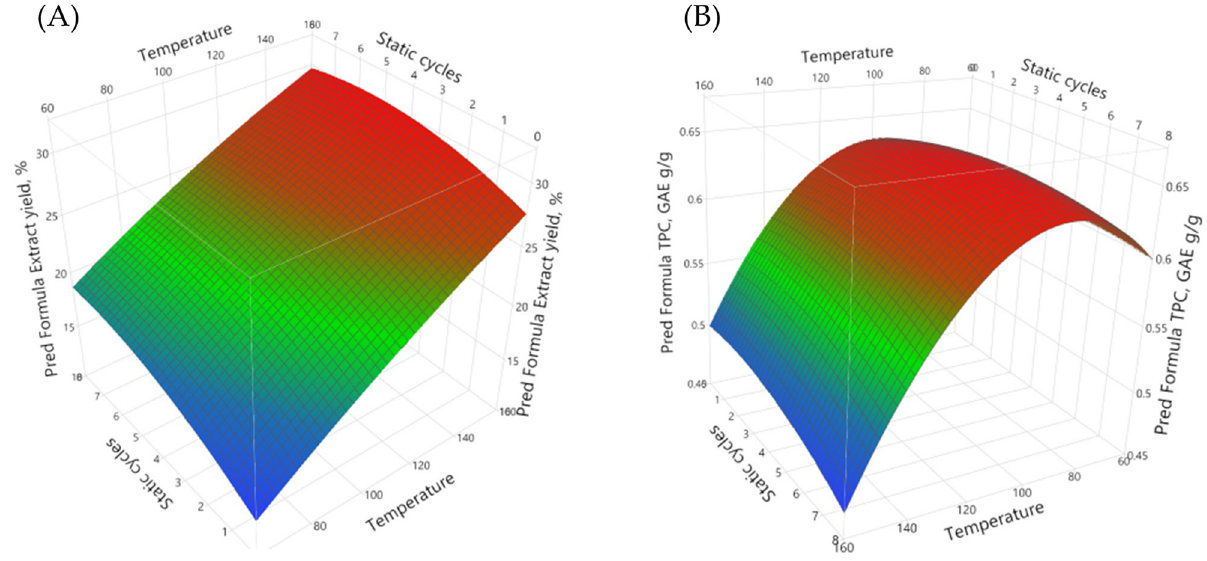
Figure 3. Surface plots of extraction yield ( A ) and TPC content in the extract ( B ) dependence of extraction conditions.